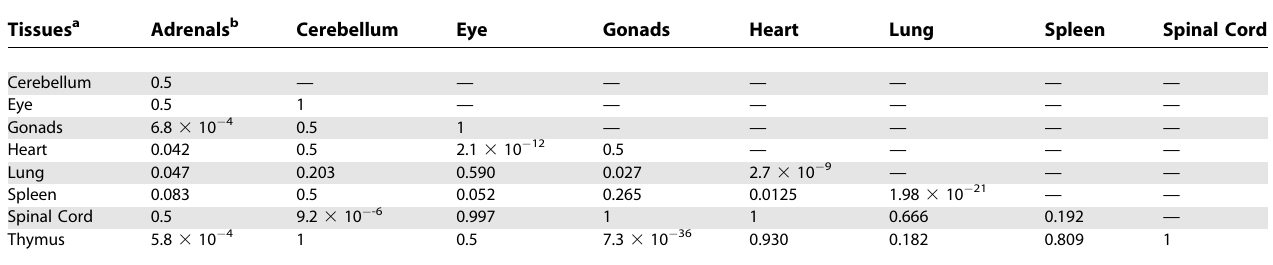
Table 2. Similarities of Age Regulation for Nine Mouse Tissues Tissues